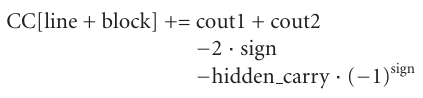
Algorithm 2: Pseudocode for CCA